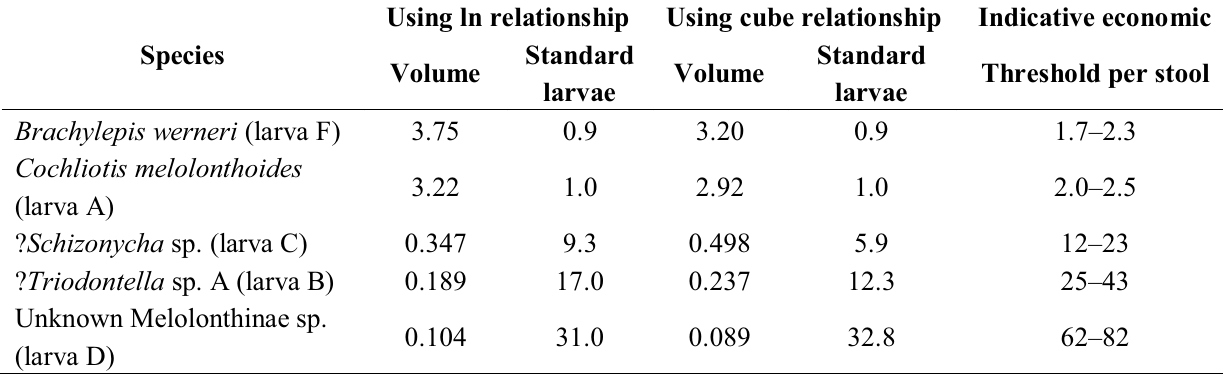
Table 10. White grub volumes for final instars of different species calculated from fitted equations, their equivalence in terms of (cid:179) standard larvae (cid:180) (the mean volume of L3 Cochliotis melolonthoides ), and indicative economic thresholds (the lowest and highest figures obtained using the two derived